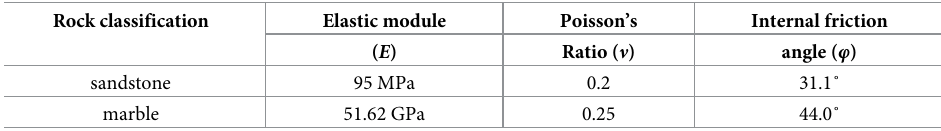
Table 1. Mechanical parameters of sandstone [38] and marble